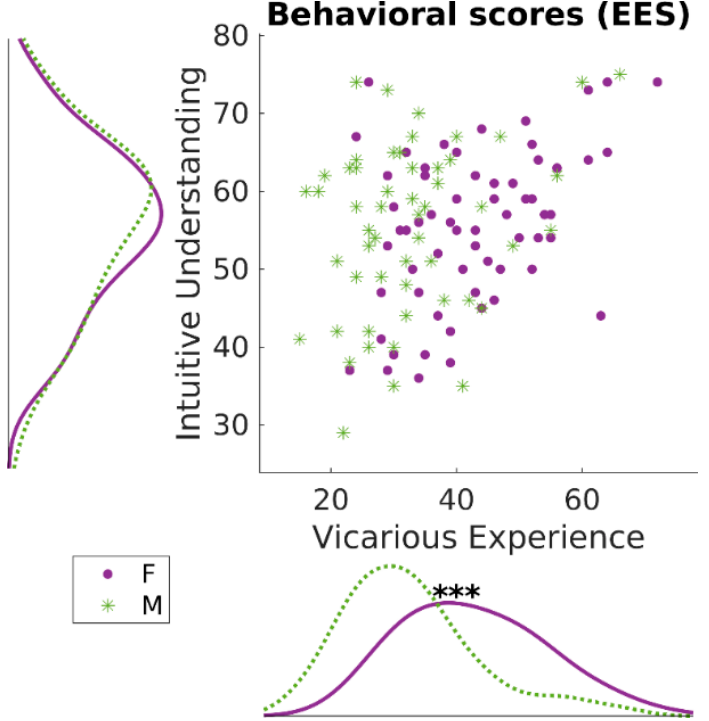
Figure 1. Behavioral Results. The two subscales of the Empathic Experience Scale were moderately positively associated ( r = 0.315). Furthermore, while intuitive understanding scores were equal across females and males ( p = 0.99), vicarious experience scores were higher in females ( p < 0.001: ***), confirming the results from previous studies [13].